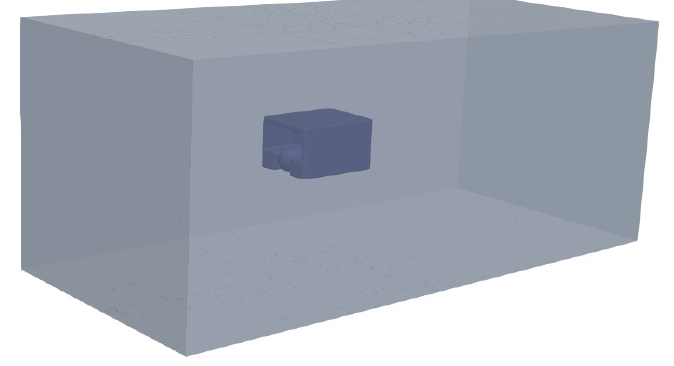
Figure 4. Sketch of the 3D computational domain.